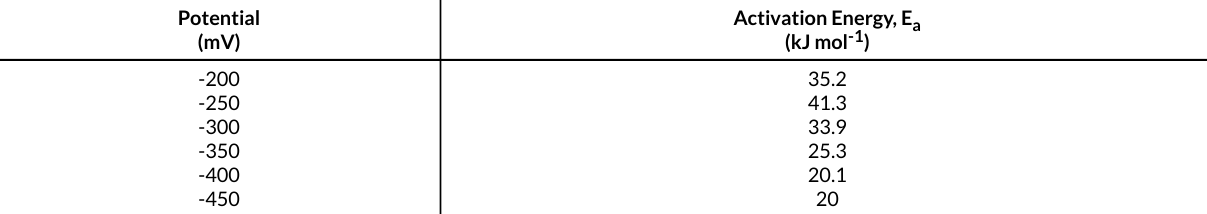
Table 1. Energy of activation values at different potentials for Pd NPs for methanol